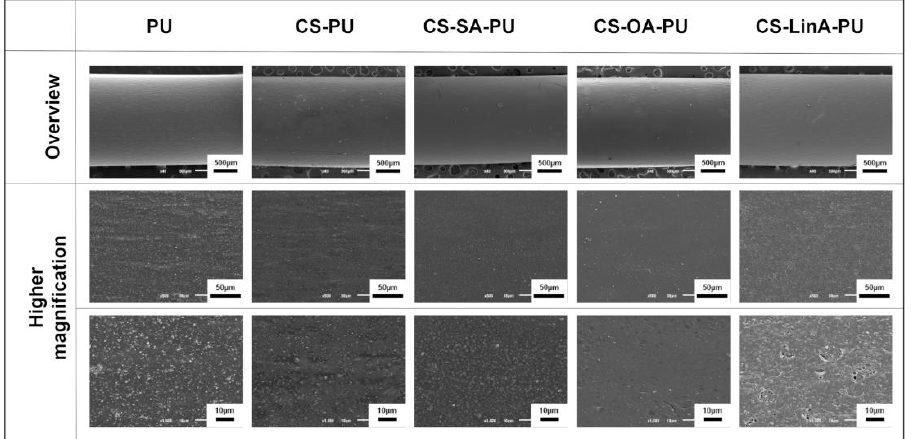
Figure 9. Representative SEM micrographs of the outer surface of untreated PU stent (control), CS- CS-PU, CS-SA-PU, CS-OA-PU and CS-LinA-PU. The scale bars are 500 µ m, 50 µ m, and 10 µ m from PU, CS-SA-PU, CS-OA-PU and CS-LinA-PU. The scale bars are 500 µm, 50 µm, and 10 µm from top top to to bottom.